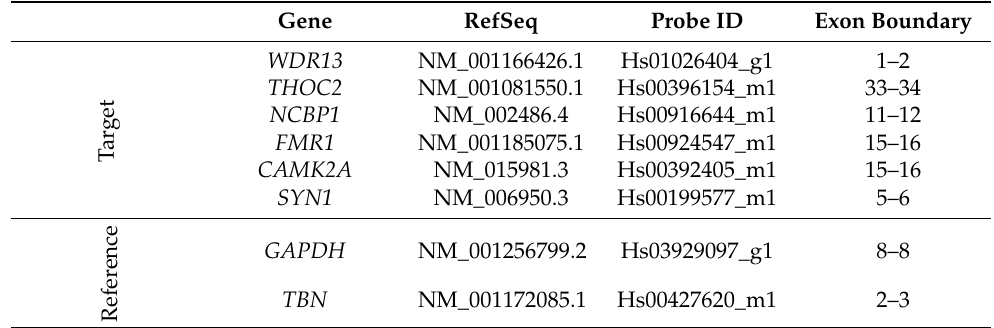
Table 1. List of probes used for qPCR.